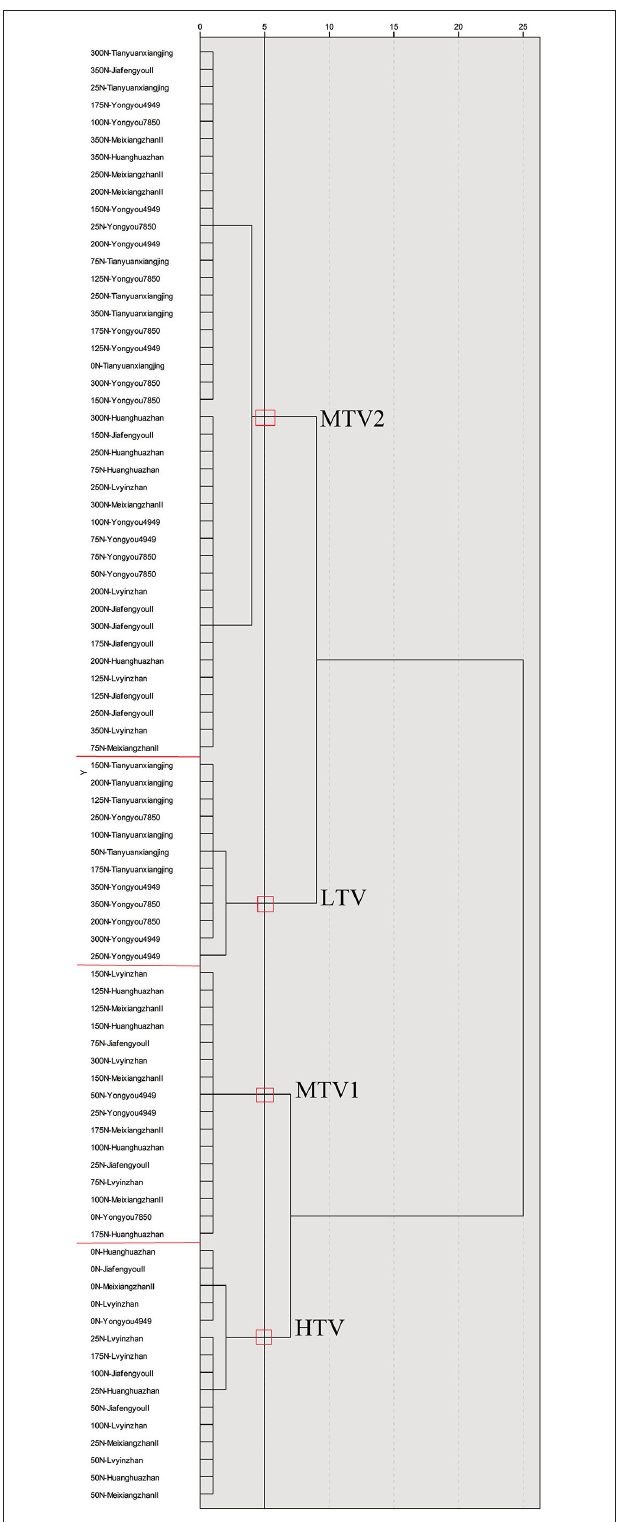
FIGURE 1 | Distribution chart of protein content, amylose content, and taste values with different nitrogen fertilizer treatments. The value of different lowercase letters refers to significant difference at P < 0.05.